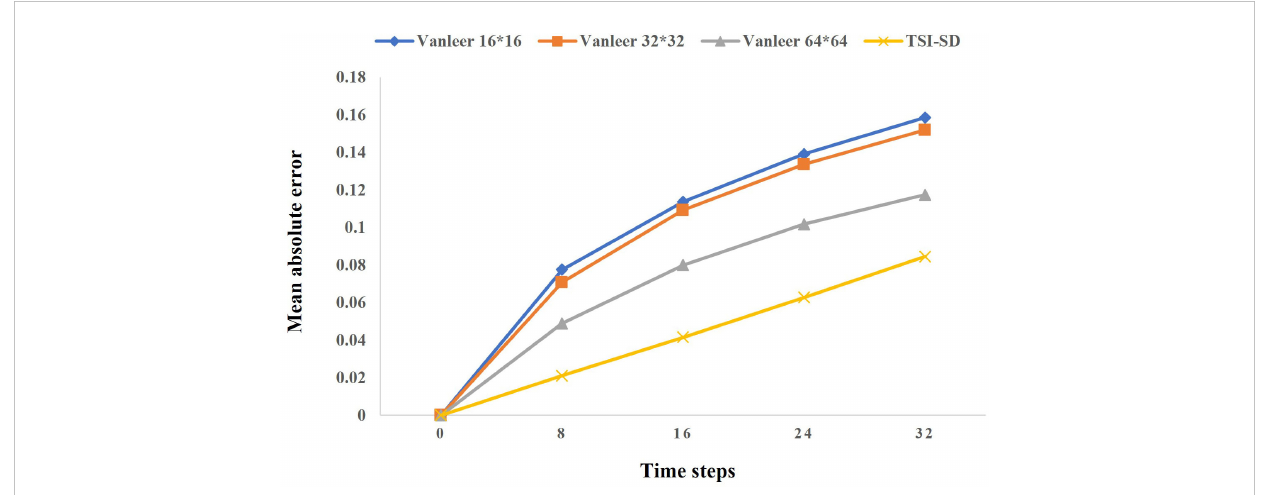
FIGURE 4 Results of our solver compared to traditional solvers. The yellow line represents our error in the 32-step iteration prediction, and the remaining three lines represent the error of the traditional solver at different